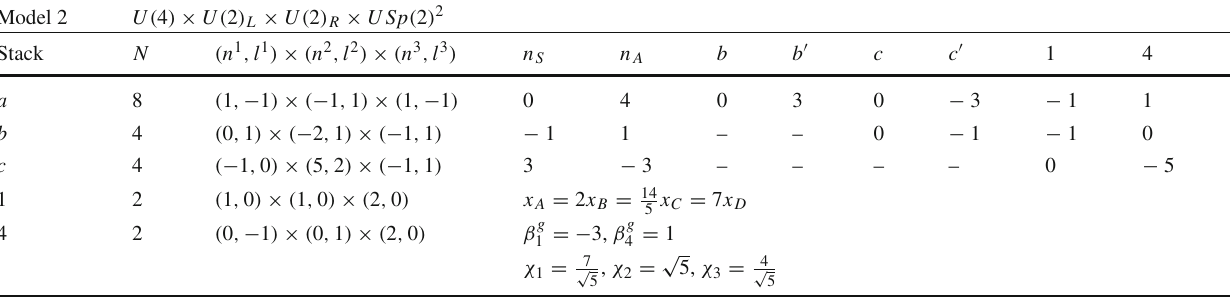
= 5 ( 5 ) = g 2 g 2 c = 25 g 2 b Y 6 6 28 3